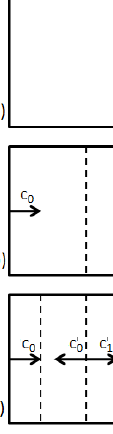
Figure 11. Wave rebound in the specimen during dynamic testing. c 0 < c 1 < c 2 . ( a ) Initial wave propagation at velocity c 0 . ( b ) Reflection of the first wave arriving at the output bar. ( c ) Interference of both waves at an intermediate point of the specimen, while new waves with velocity c 2 are created at the input bar interface.